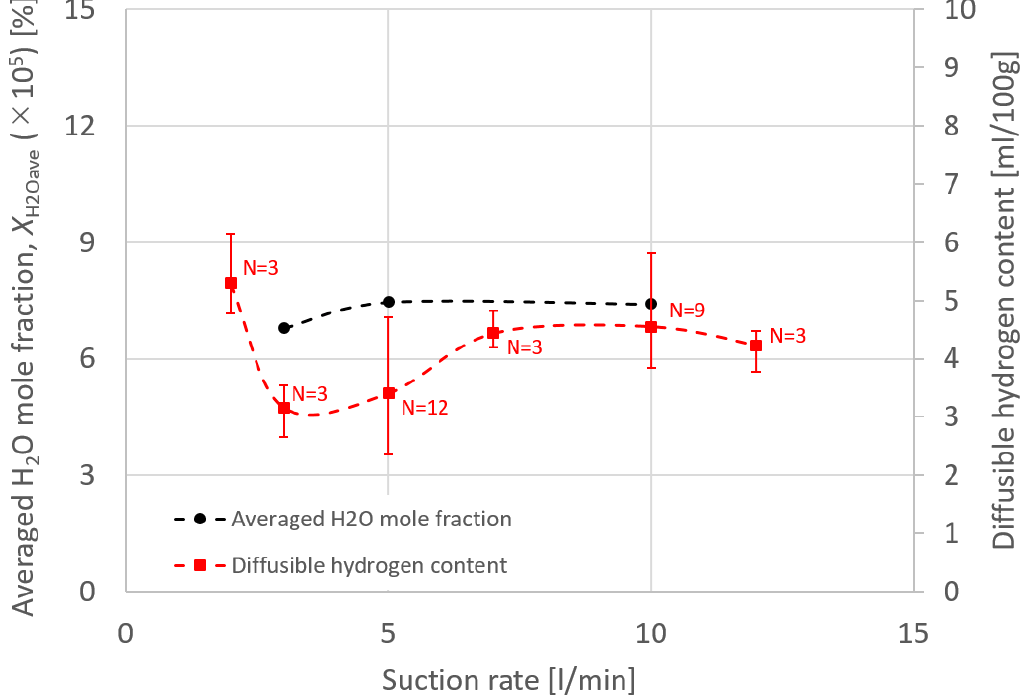
Figure 13. The measured diffusible hydrogen content and the averaged H 2 O mole fraction as a function of the suction rate.